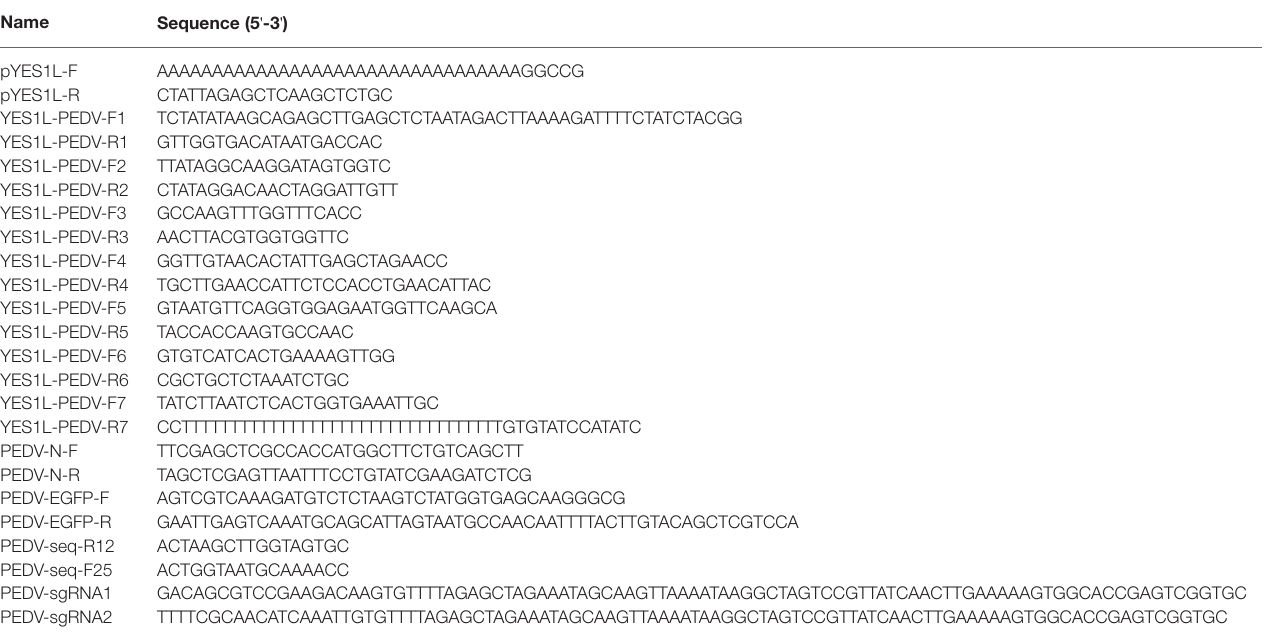
TABLE 1 | Oligonucleotides used in this